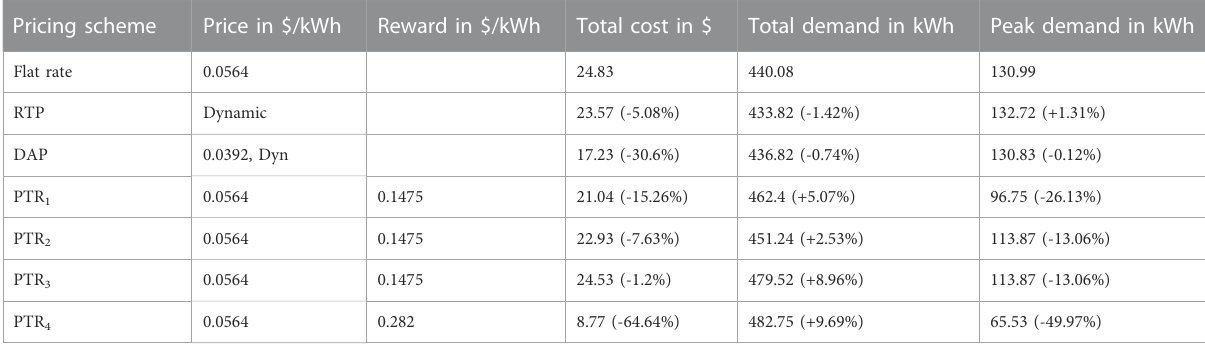
TABLE 3 Results of February 05. Pricing